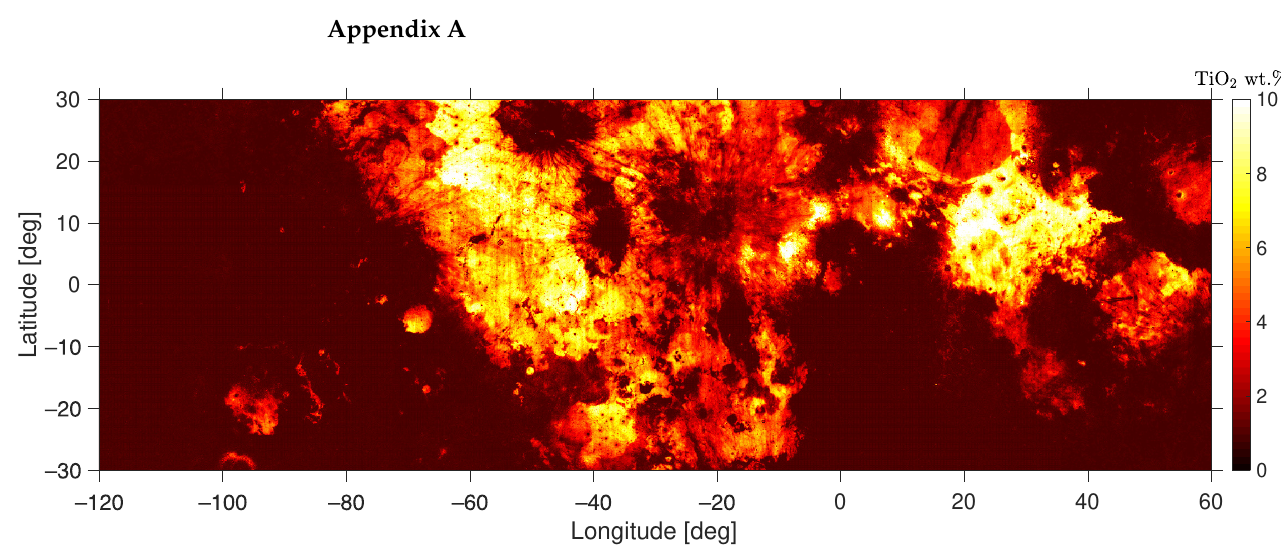
Figure A1. TiO 2 content in the equatorial mare regions from Sato et al. [24].